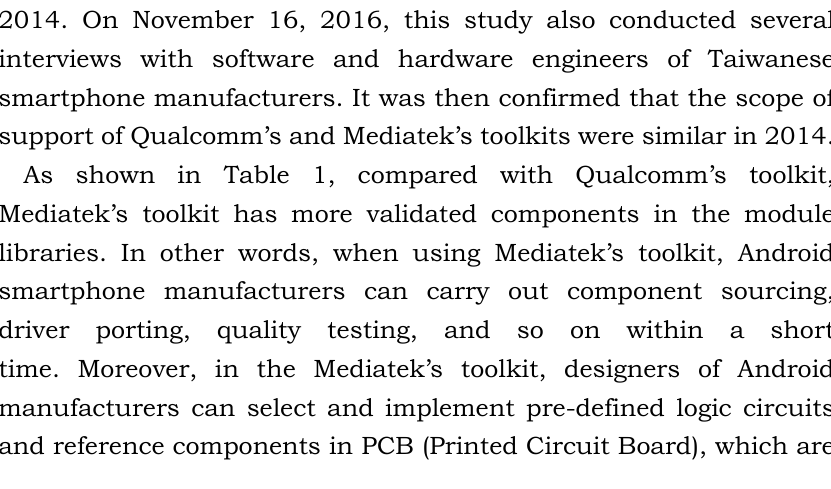
Table 1. The scope of support of Qualcomm’s and Mediatek’s